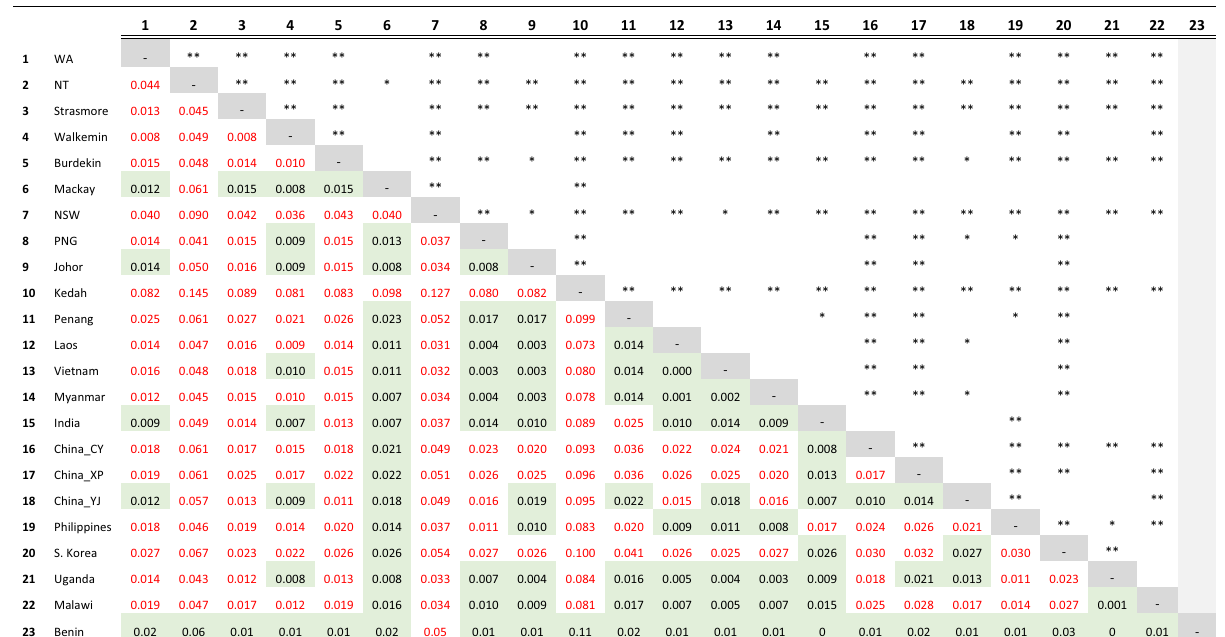
population are listed in Table 1. Nucleotide diversity (π) varied across a narrow range with the lowest (0.237) being from the Malaysian Kedah State population (i.e., reflected its lab-colony background), and the highest from the Malawian population (0.324), similar to that reported ( 33 ; π = 0.279–0.329) in native and invasive popu- lations based on the same set of 870 SNP loci. The high nucleotide diversity estimates from the SEA, Australia and South Korean populations likely reflected effects of limited (i.e., 870) highly polymorphic SNPs from non- coding genomic regions being used, and are comparable to the findings from Tay et al. 33 that used the same sets of SNP loci. We did not detect significant overall differences between the various invasive populations, and for the SE Asian and Australian populations the nucleotide diversity estimates were generally between 0.258 and 0.291. All invasive populations from Africa (Benin, Malawi, Uganda), SA/EA (India, China (CY, XP, XJ), South Korea), SEA (Malaysia (Johor, Kedah, Penang), Laos, Vietnam, Myanmar, Philippines), and Pacific (PNG)/Aus- tralia (WA (Kununurra), NT, QLD (Strathmore, Walkamin, Burdekin), NSW (Wee Waa)) showed higher aver- age observed heterozygosity (Het obs ) than the average expected heterozygosity (Het exp ), with the highest Het obs seen in the Malawian population as also reported previously 33 . Within the Australian populations, highest aver- age observed heterozygosity was seen in the Strathmore population, while in populations in SEA (i.e., Myanmar, Philippines) and the EA (i.e., South Korea) all showed similar average Het obs . Negative average F IS values for all populations were consistent with Het obs being higher than Het exp , and suggested populations were out-breeding (i.e., avoidance of matings between related individuals; 59 ). Similar to the previous findings 33 , the lower Het exp (i.e., Het obs > Het exp ; see 60 ) could likewise indicate recent mixing of distinct populations from SEA that suggest multiple introductions (e.g., 33,39 cf. 46,47,61,62 ; i.e., due to a recent bottleneck from a recent western Africa founder event). The observed heterozygosity excess detected in all invasive range populations could be further explained as due to population sub-structure and isolation breaking through periodic migration. Significant numbers of loci ( ca . 30%) were also shown to not be in Hardy–Weinberg equilibrium (HWE) especially for the Malaysian (i.e.,